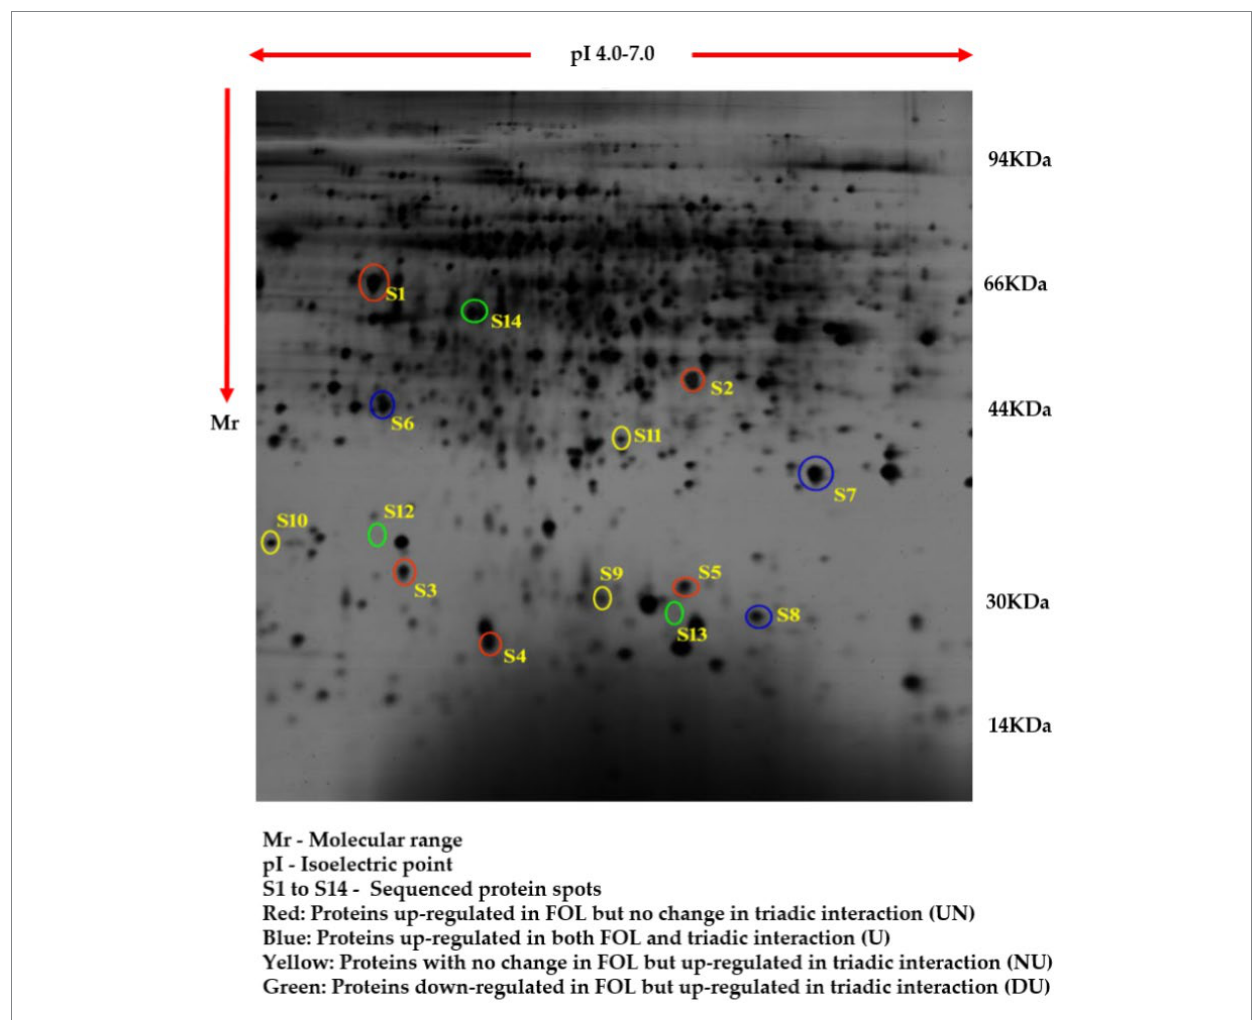
FIGURE 7 Proteome analysis of FOL pathogen inoculated in tomato roots by